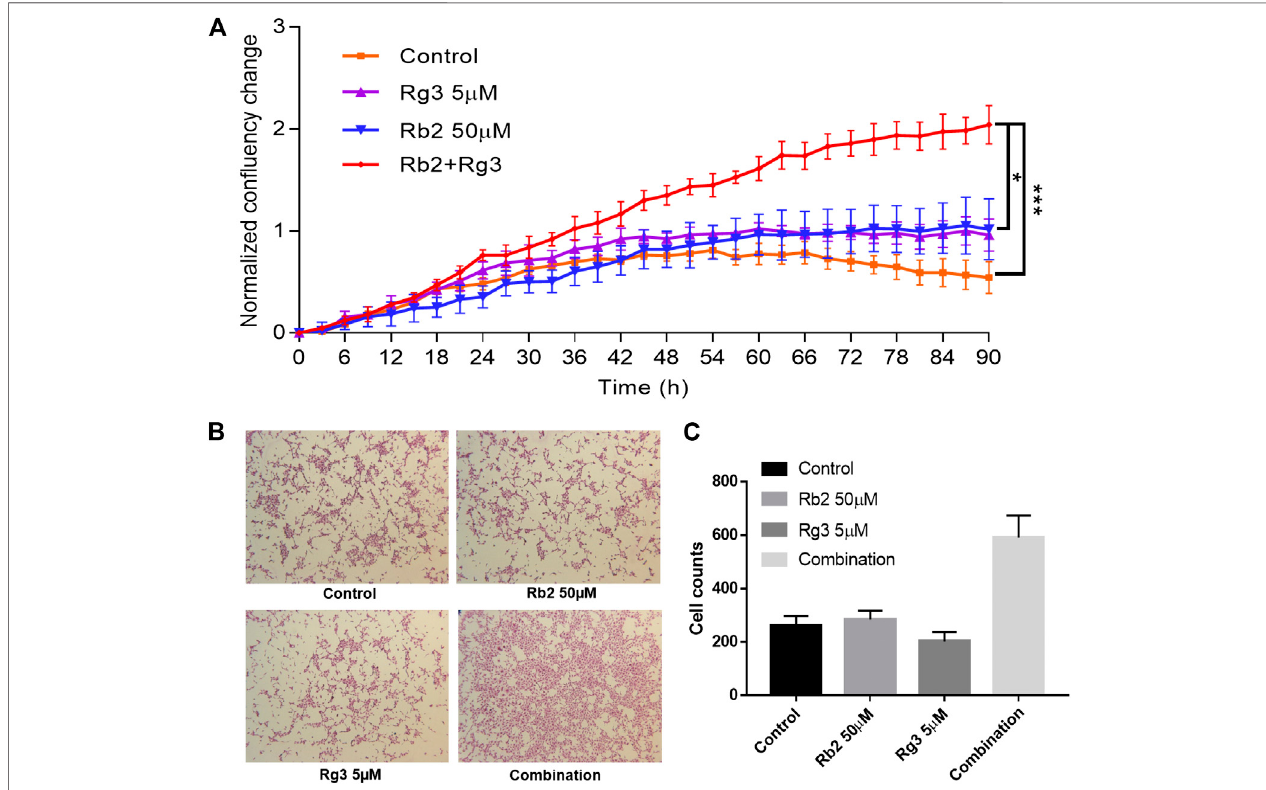
FIGURE2| Effect ofginsenosidesRg3andRb2 onHUVECproliferationasmonitored bycon fl uenceofcellimagesevery3 hupto90 h (A) .Themean foldchange in con fl uence from the vehicle or compound alone or combination-treated group is shown. Con fl uence is a suitable surrogate for proliferation and cell growth over